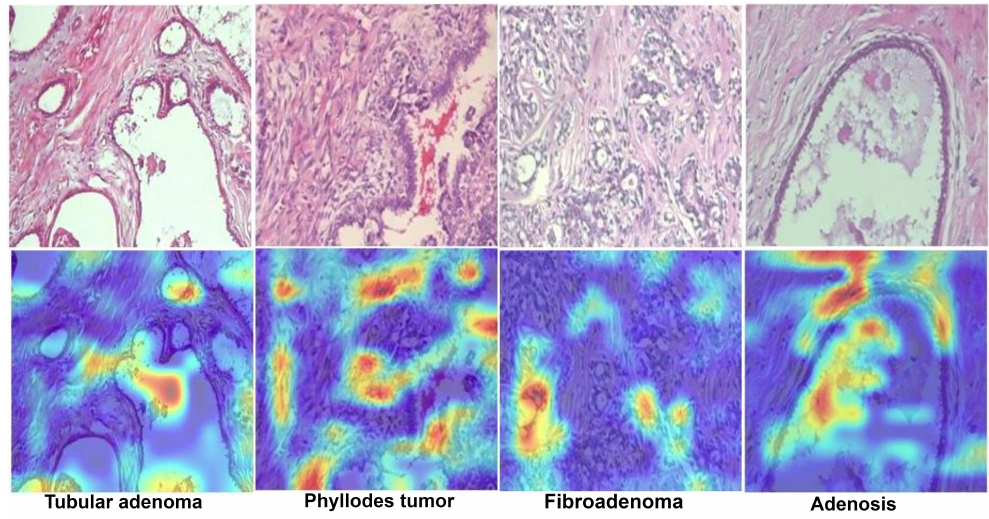
Figure 15. Sample of regions of interest generated by Grad-CAM (top = benign subtypes original images, bottom = benign Grad-CAM heatmap.